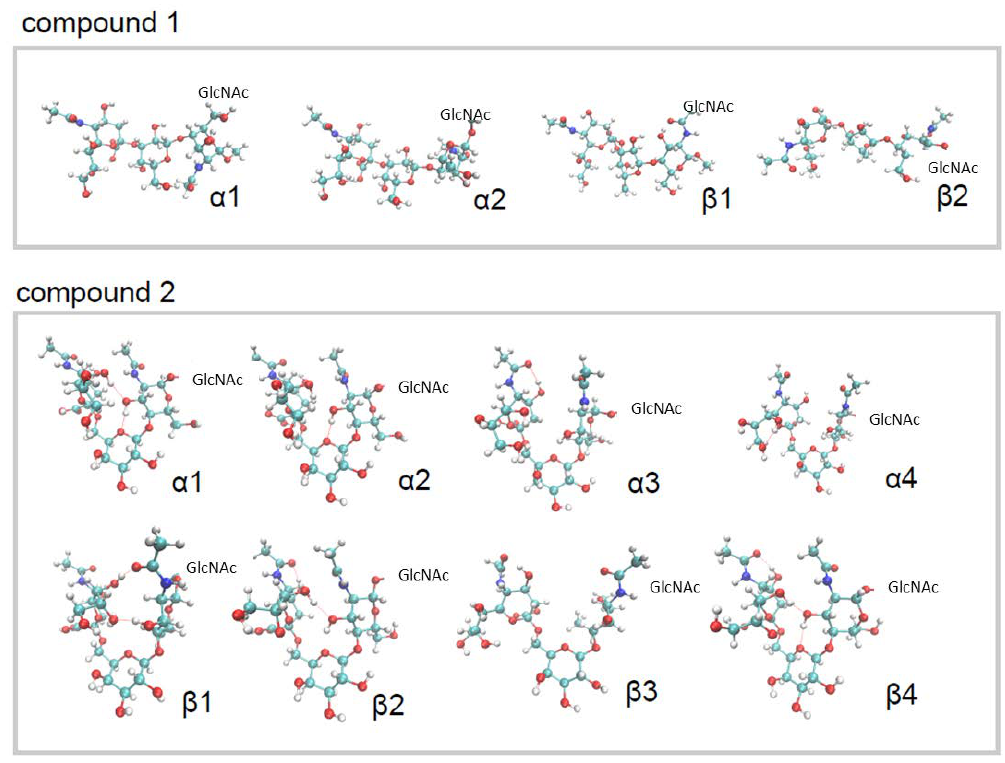
Figure 3. Conformational ensembles obtained for compounds 1 and 2 . Dashed red lines indicate hydrogen bonds.